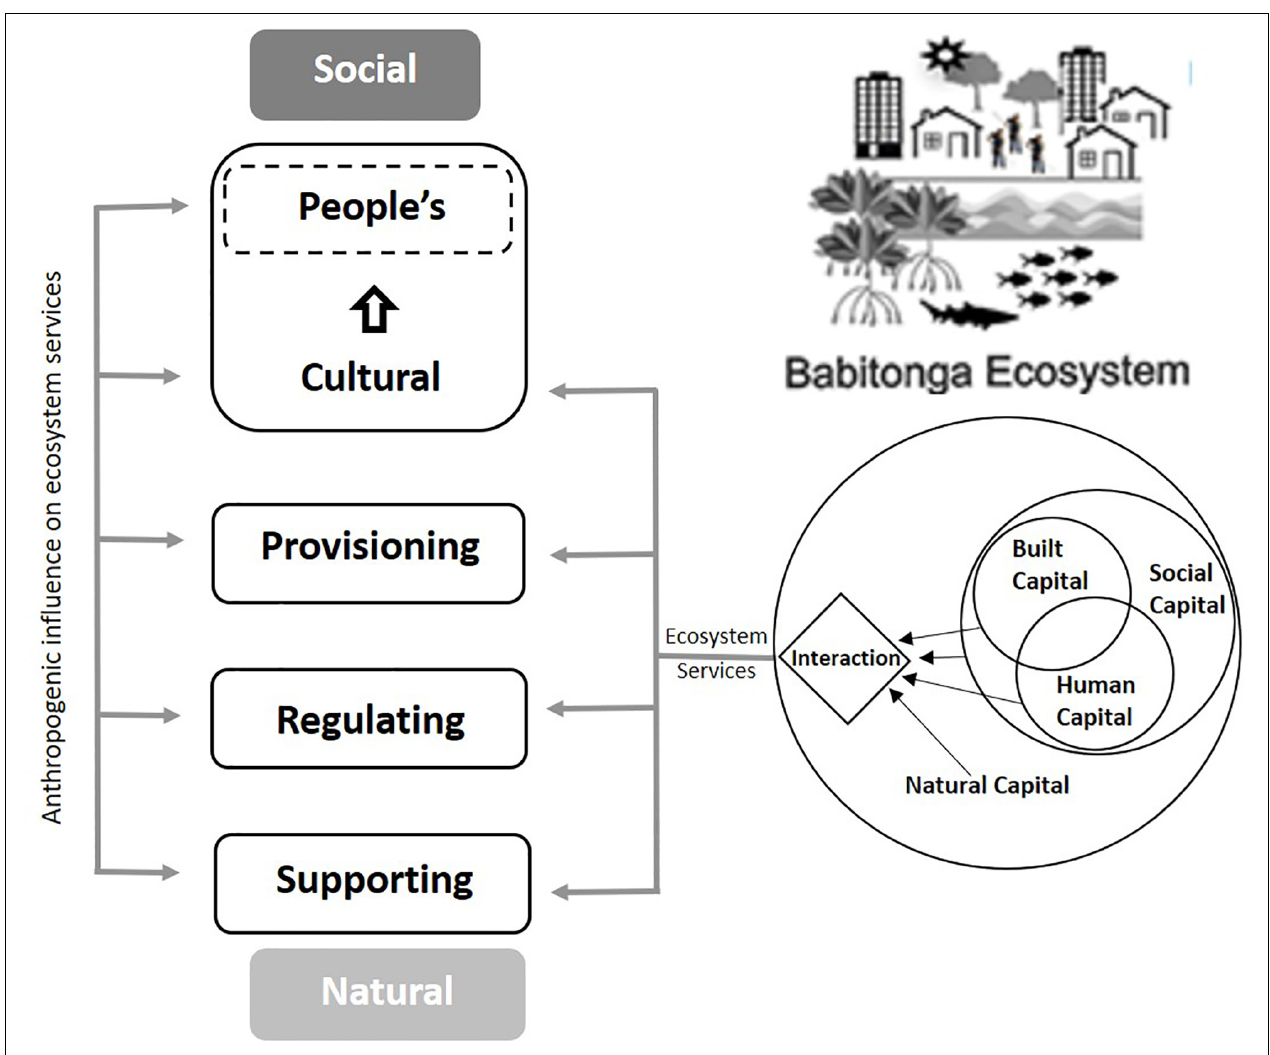
FIGURE 5 | Connections between ES arranged in an interdependent, nested gradient within the focal social-ecological system (e.g. Babitonga Bay ecosystem). We acknowledge that ES as well as complex cascading effects results from the interaction of different types of natural capitals (including non-human derived natural capital, social, human and built capitals; interconnected arrows to the right). Services (etic) or benefits (emic) are perceived by social-ecological system’s agents (direct ecosystem users and researchers in the Babitonga Bay ecosystem case study), the structure of which vary from less (Supporting, Regulating, and Provisioning) to more socially dominated (Cultural including People’s) types of ES. The interconnected arrows to the left therefore show humans influence on one or more service, not necessarily in one direction, e.g. change in cultural/people’s services can influence provisioning and regulating services, and/or all other services in multiple ways) (adapted from Costanza et al.,